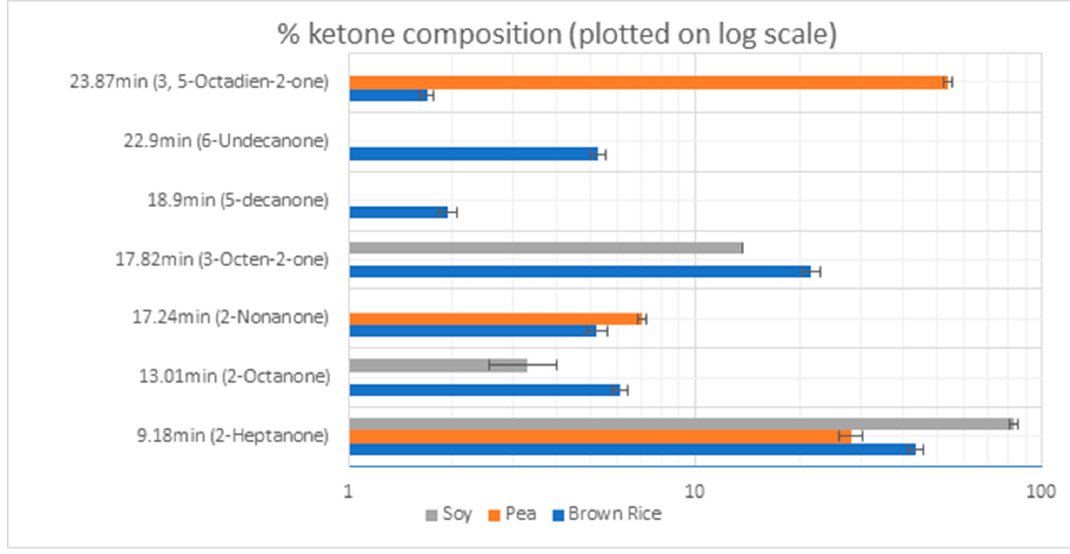
Figure 3. % ketone composition in the plant protein